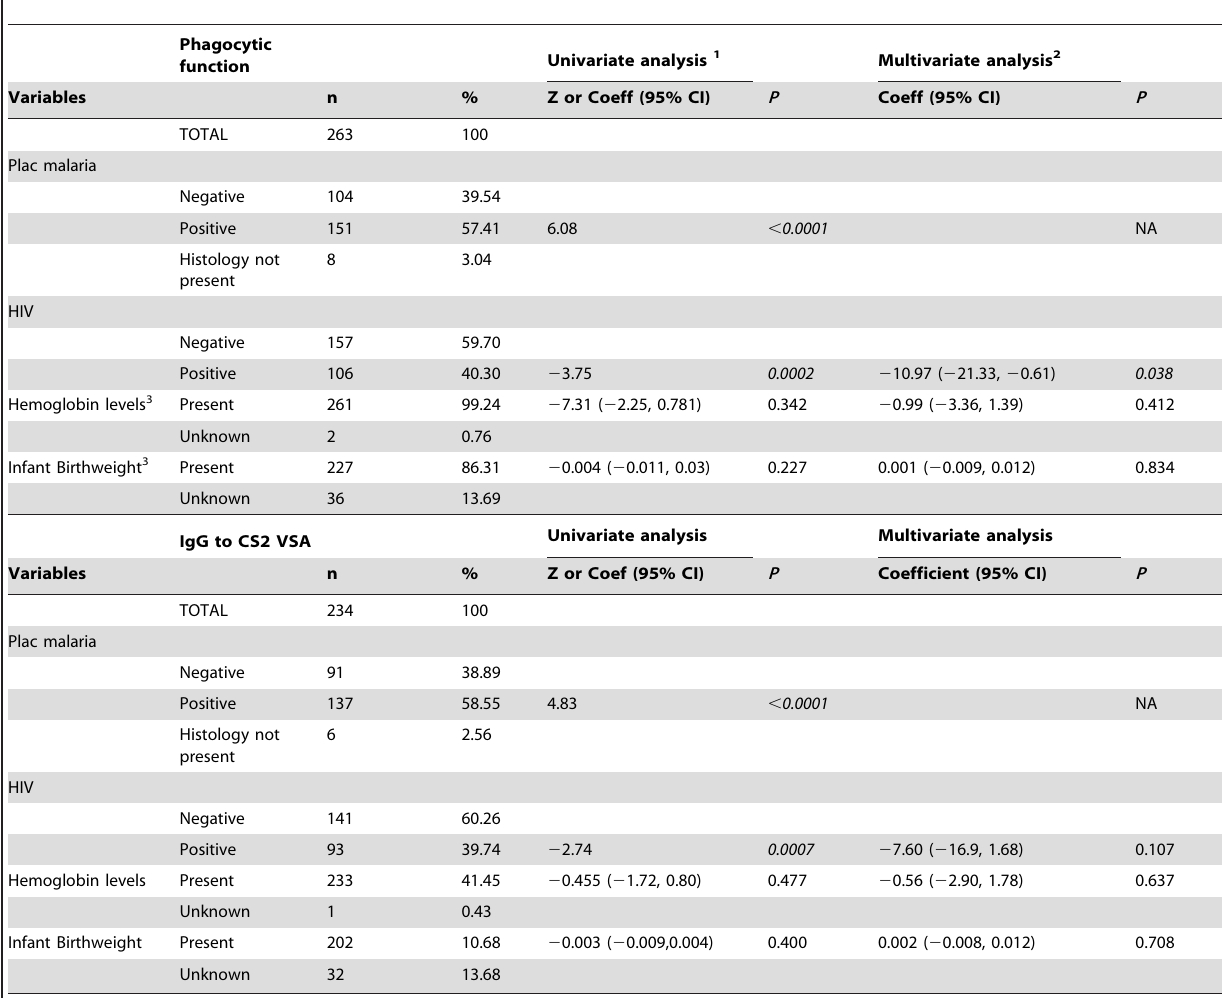
Table 3. Association between indicated characteristics and PiAs function or IgG to CS2